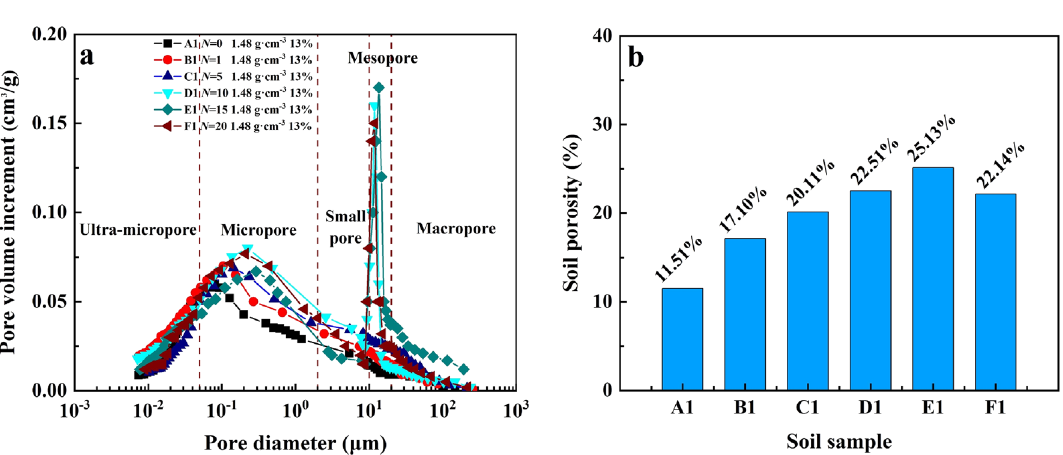
Figure 10. Pore-size distribution cures and bar chart of soil porosity distribution for soils at the study site in the floodplain of southwestern Shandong Province: ( a ) The water content is 13% and the dry density is 1.48 g cm −3 , pore-size distribution curves with different F–T cycles. ( b ) Bar chart of soil porosity